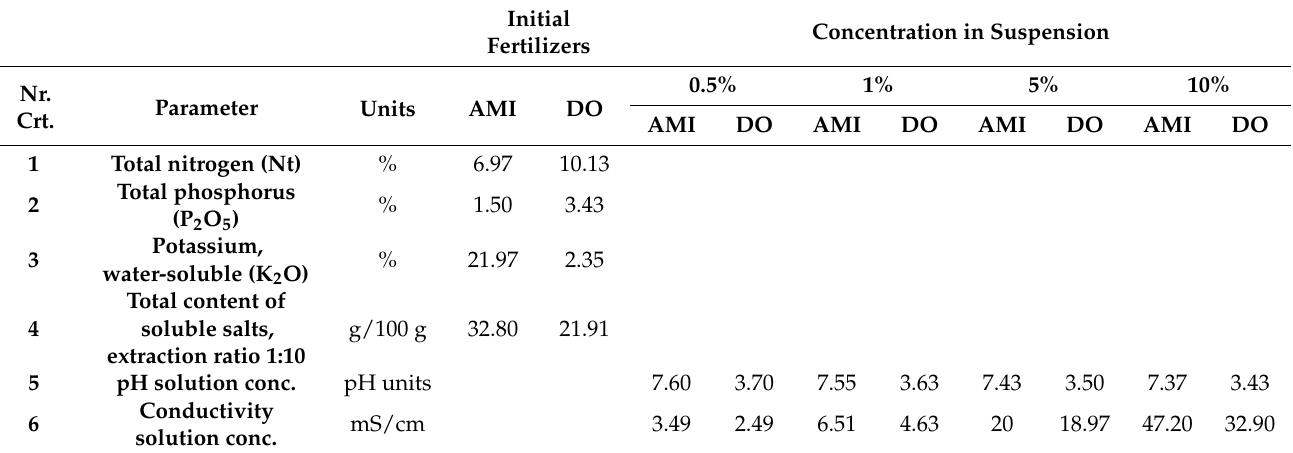
Table 2. Nutritive characteristics of hydrogels functionalized with starch (AMI) and dolomite (DO).